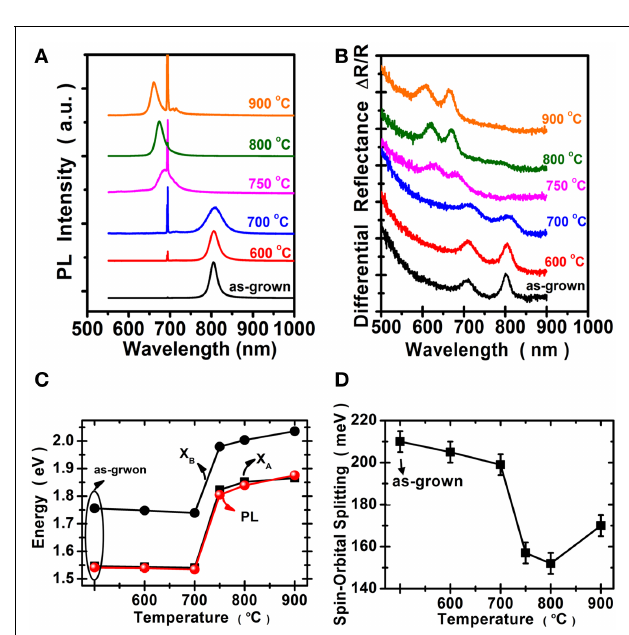
FIGURE 4 | Optical properties of MoS 2 selenization are collected for the samples before and after selenization: (A) Photoluminescence spectra, the peak at 694nm was from the sapphire substrate. (B) Absorption spectra. (C) The optical energy gap of (A,B) , exciton, and PL peaks. (D) The spin–orbital splitting derived from the absorption spectra.